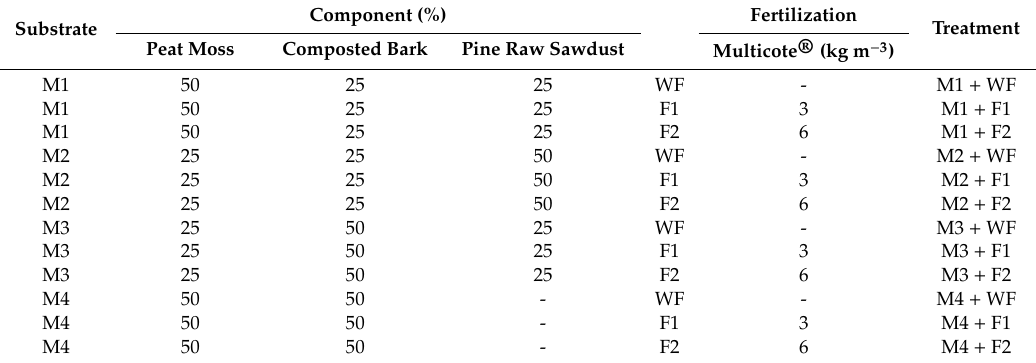
Table 1. Substrates and fertilization doses evaluated in the production of Pinus cembroides Zucc. under nursery